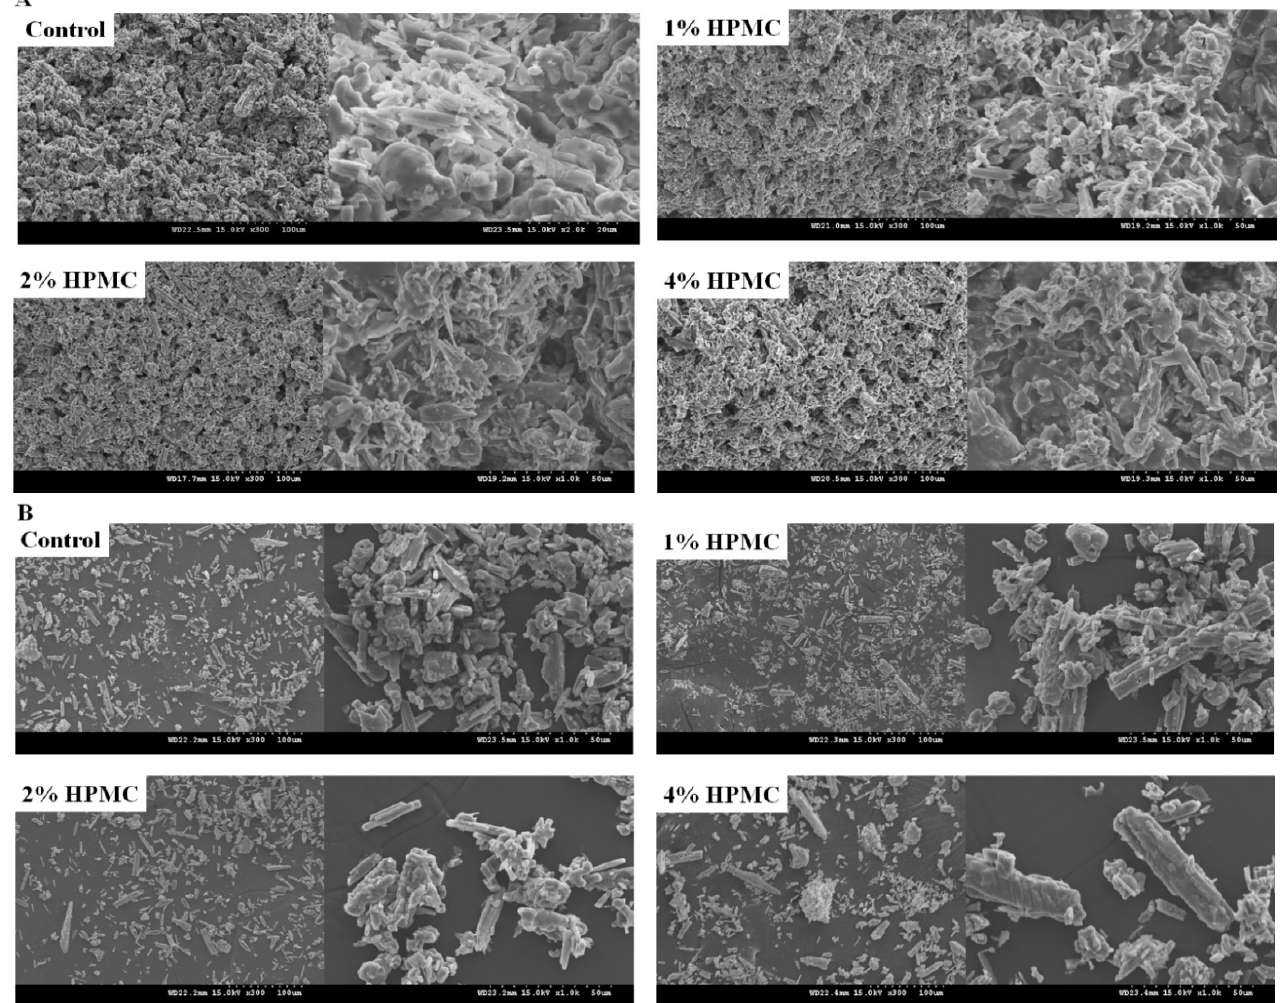
Figure 3. SEM micrographs (300 × and 1000 × ) of premixed putty containing HPMC with different mass ratios after being soaked for 4 h. ( A ) Micrographs of the main body. ( B ) Micrographs of particles.